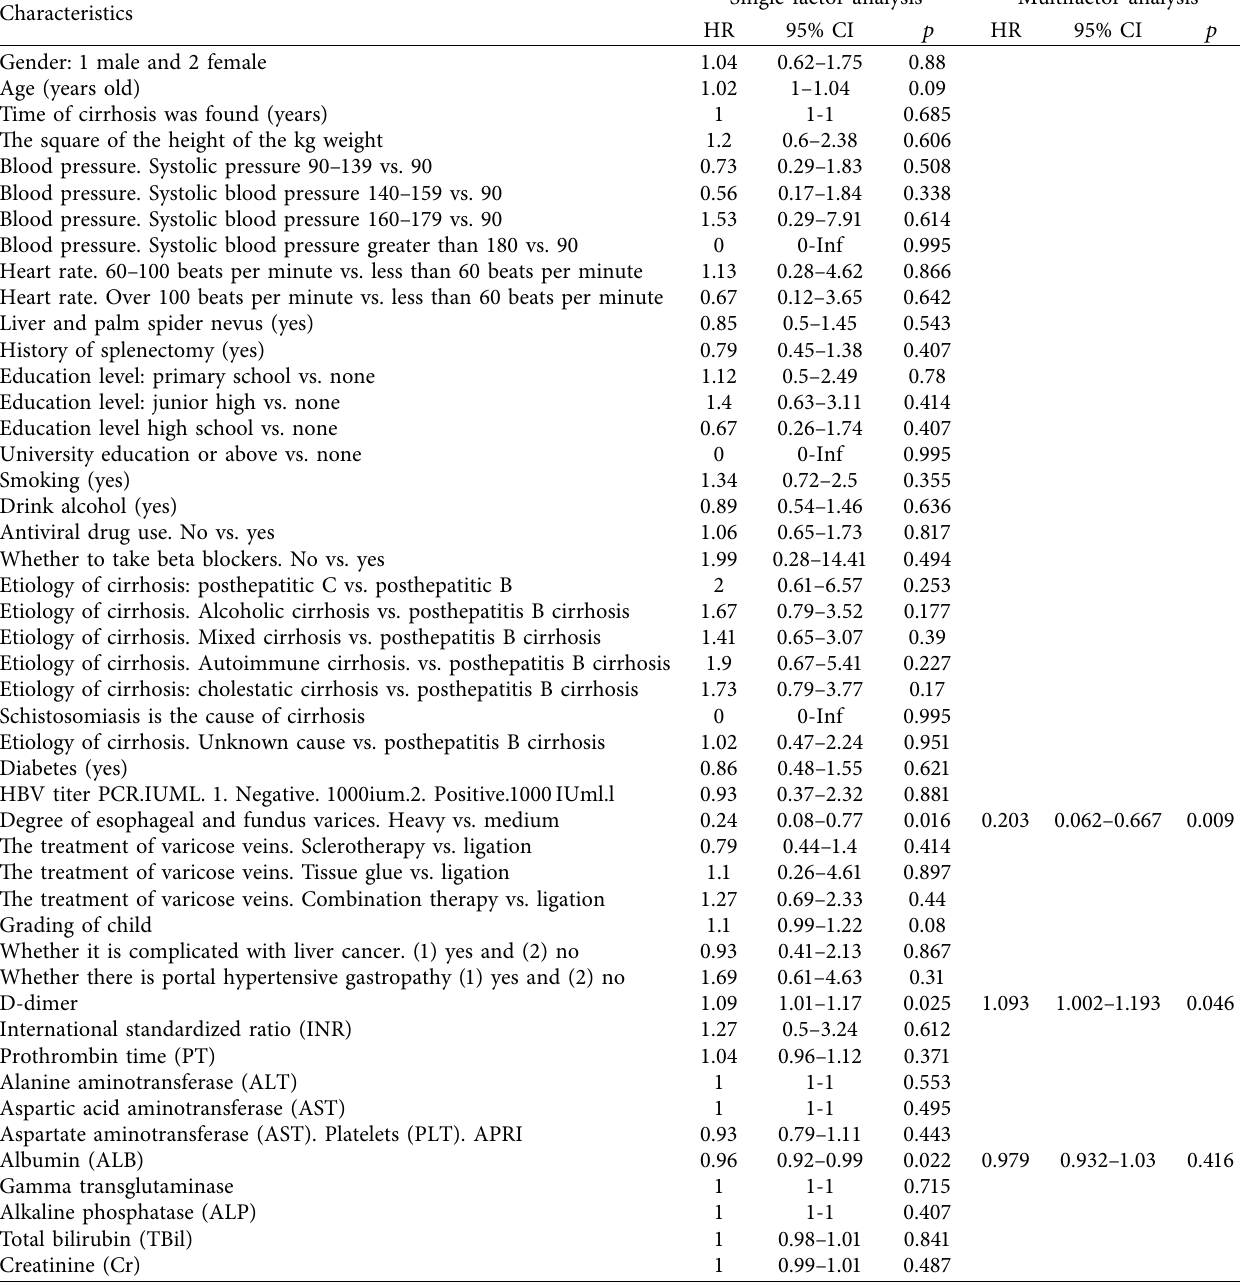
Table 4: Univariate and multivariate analyses of factors afecting the occurrence of infection in liver cirrhosis patients during the late follow-up (Cox regression